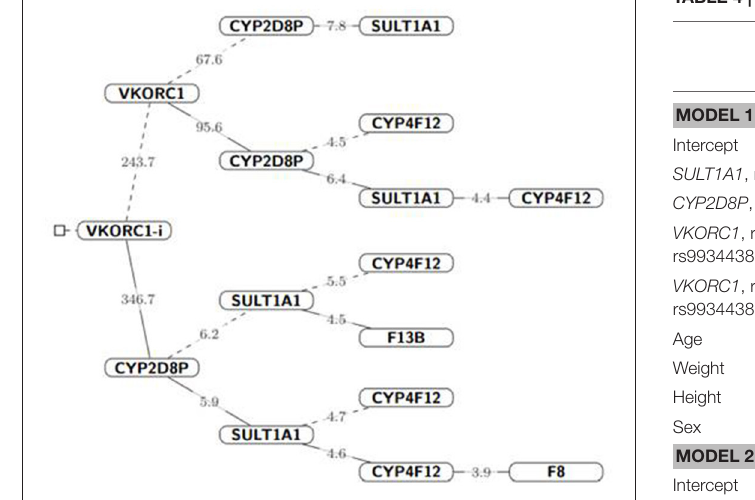
FIGURE 2 | Hierarchical tree of variants influencing acenocoumarol dose. The parent node (solid lines) represent gene variants from which other variants depend for acenocouumaorl dose estimation, i.e., all probability statement in that branch are conditioned to the probabilistic event of the parent node (gene) Iparent = 1 , dashed lines indicate that the parent node was conditioned to zero, Iparent = 0 . The number on each line represents the Bayes Factor for the following branched off node; given the cut-off values. For visualization purposes, we did not condition on CYP2D8P, which was strongly associated with high-dose values ( ≥ 40 mg/wk) in 3 of the 6 patients receiving high doses. Nevertheless, both frequentist and Bayesian hypothesis testing suggested a strong association to coumarin dose for this variant ( P -value < 0.05 and Bayes Factor > 100, respectively).